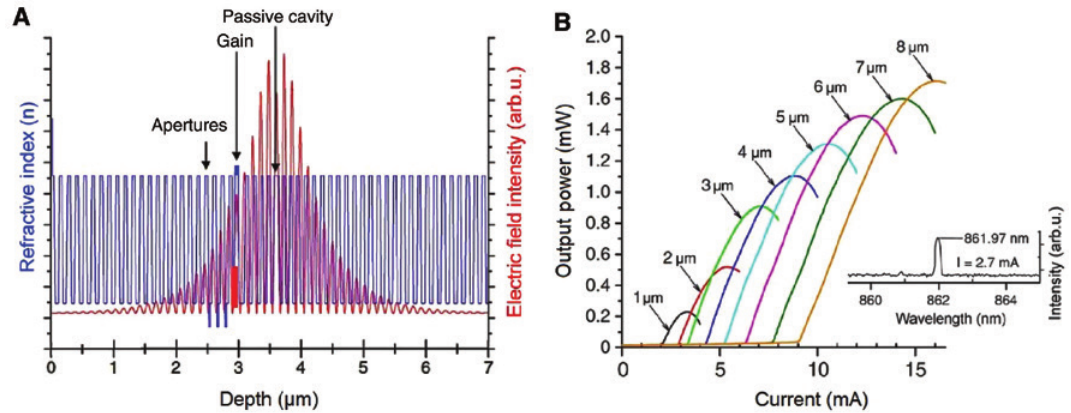
Figure 4: (A) Refractive index and longitudinal optical mode profile vs. the vertical coordinate of the passive cavity VCSEL. (B) Light-current characteristics of the devices having different oxide-confined aperture diameteres (as indicated in micrometers).